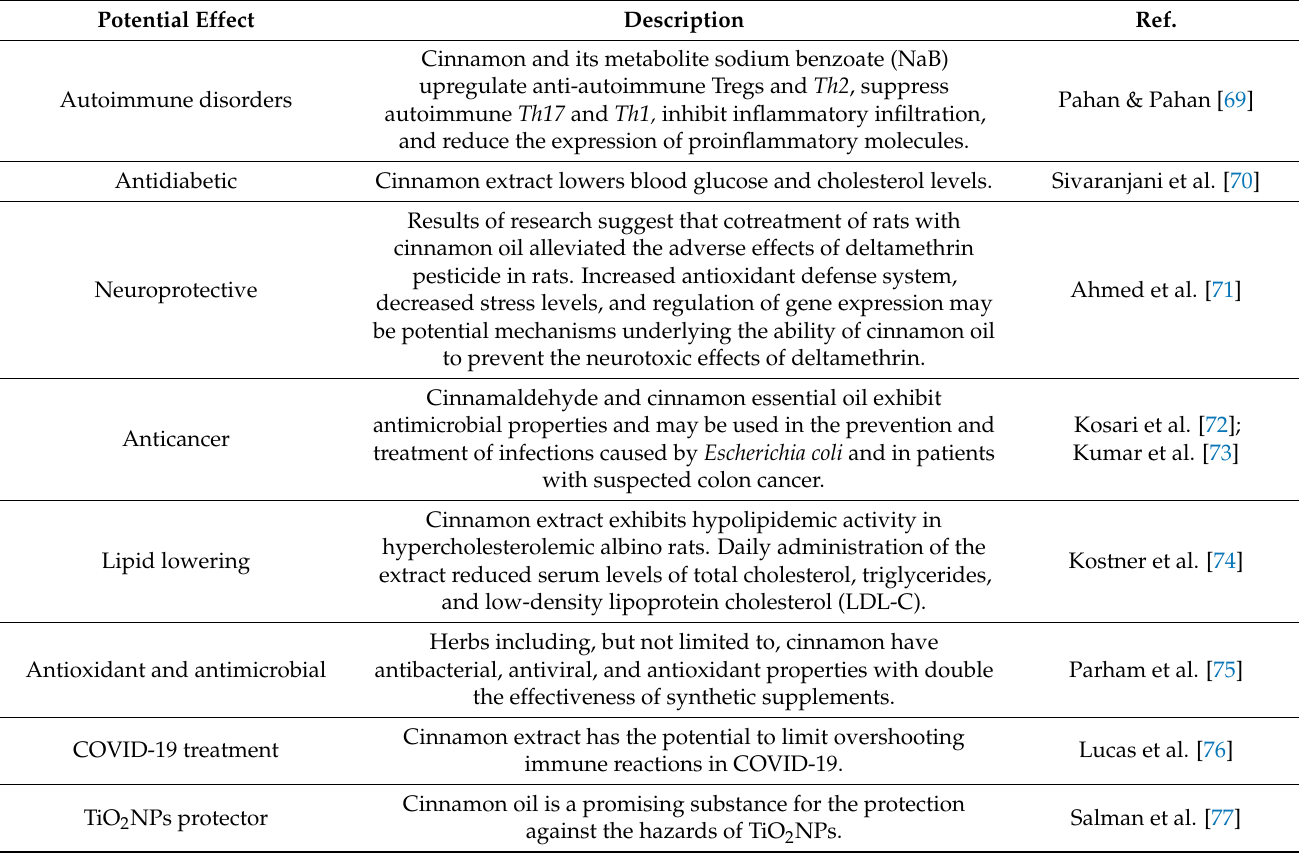
Table 2. Examples of potential application of cinnamon in human